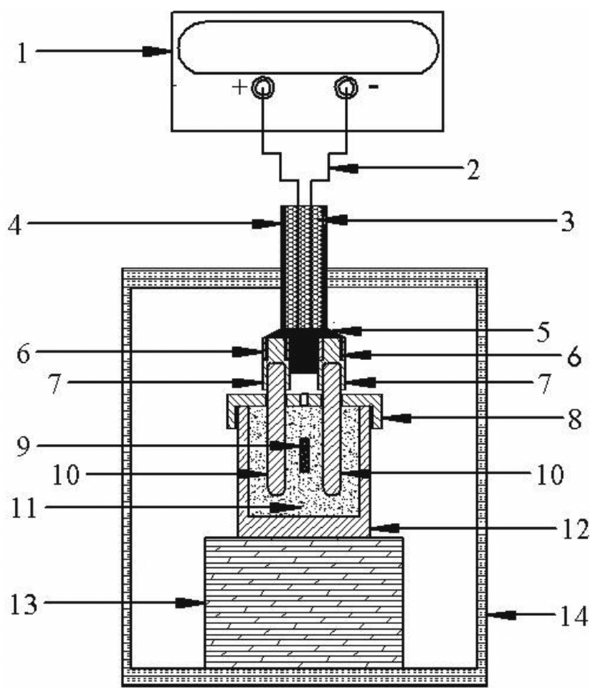
Figure 1: Schematic representation of the PBDCF system. 1: